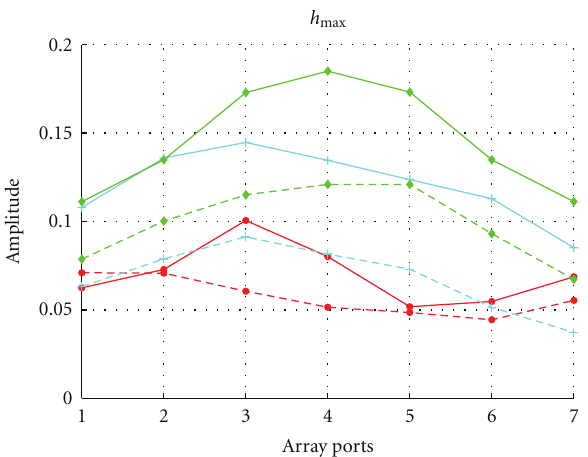
Figure 13: Output maximum transfer function: simulation and measurement.